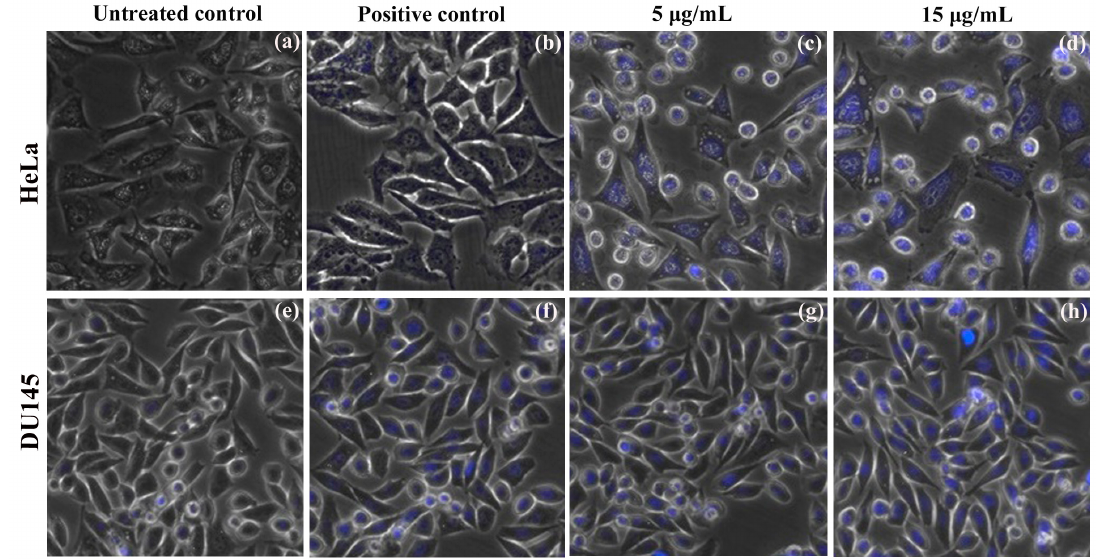
Figure 7. Nuclear staining using DAPI on HeLa and DU145 carcinoma cells observed at 20× magnification under fluorescent inverted microcope. Untreated negative controls: ( a ) HeLa, ( e ) DU145. 20 µ g / mL leaf extract taken as positive controls for ( b ) HeLa and 15 µ g / mL for ( f ) DU145. ZnO NPs treatment 5 µ g / mL: ( c ) HeLa, ( g ) DU145; and 15 µ g / mL ZnO NPs treatment: ( d ) HeLa, ( h ) DU145 cell lines.